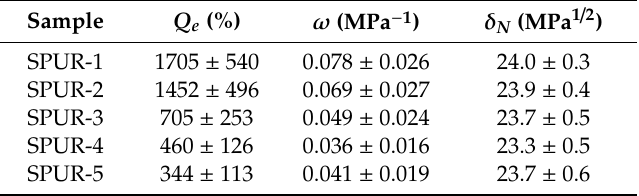
Table 2. The values of parameters Q e , ω and δ N obtained by fitting of Equation (8) to the corresponding experimental data.